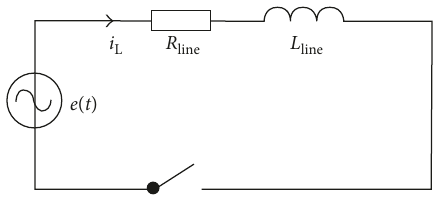
Figure 3: Equivalent circuit of the considered network.